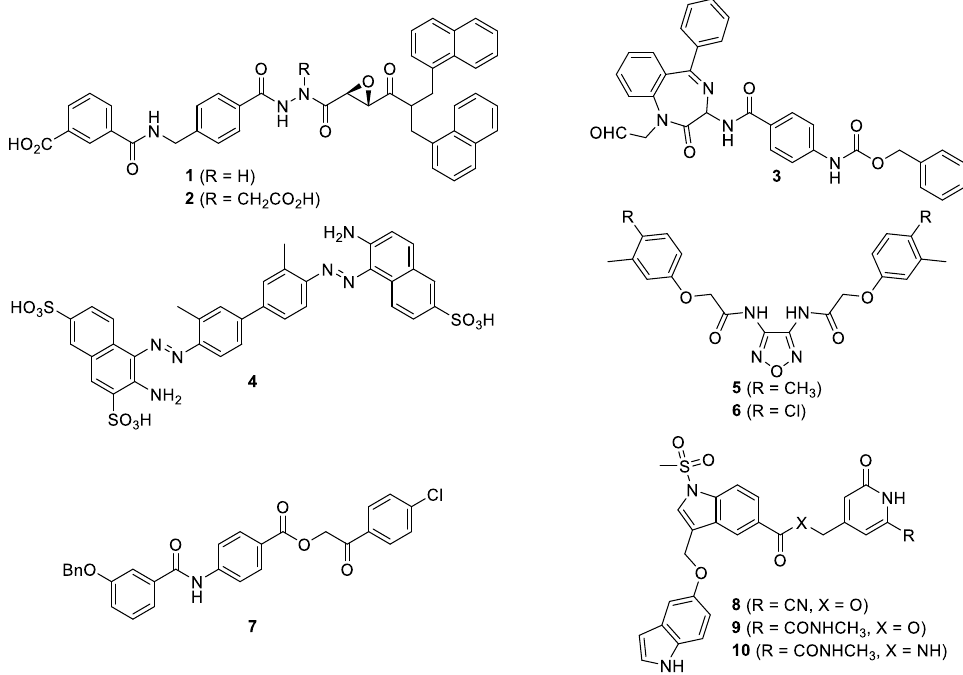
Figure 1 . Selection of reported small molecule SENP1 inhibitors ( 1 – 10 ). Figure 1. Selection of reported small molecule SENP1 inhibitors ( 1 – 10